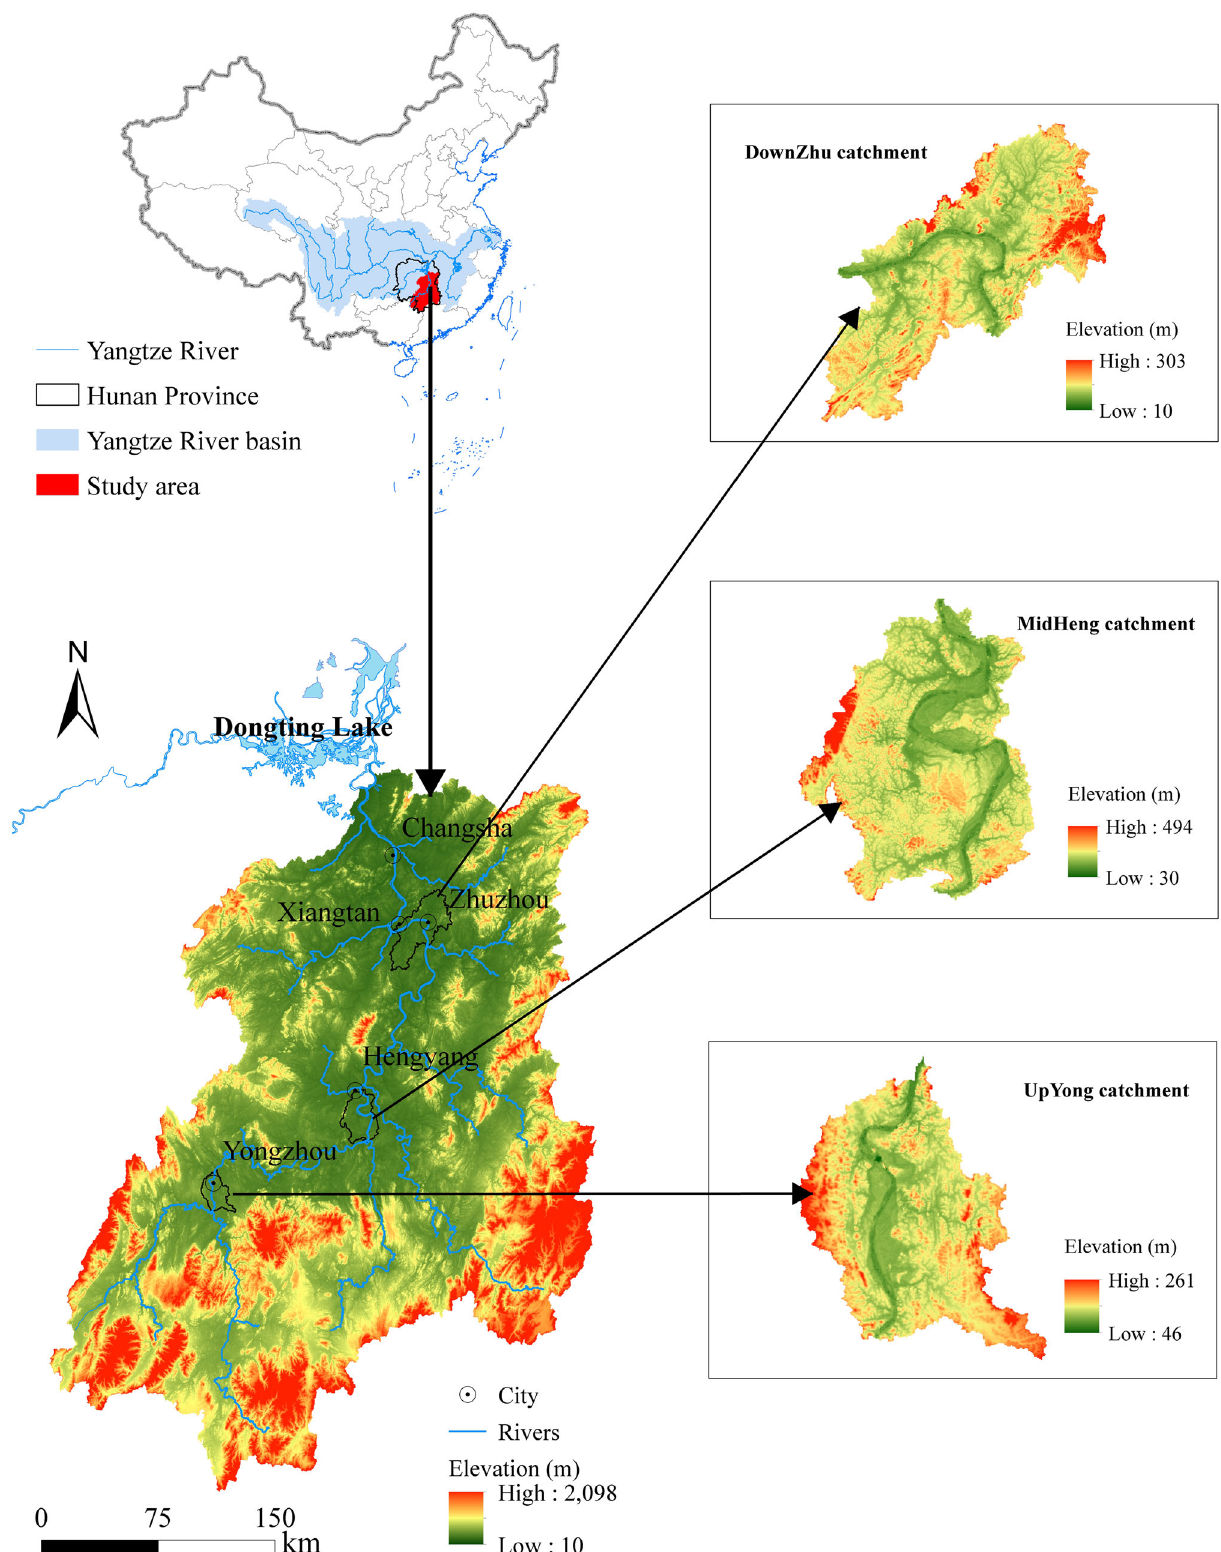
Fig. 1 Locations of the study area and major cities in the Xiang River